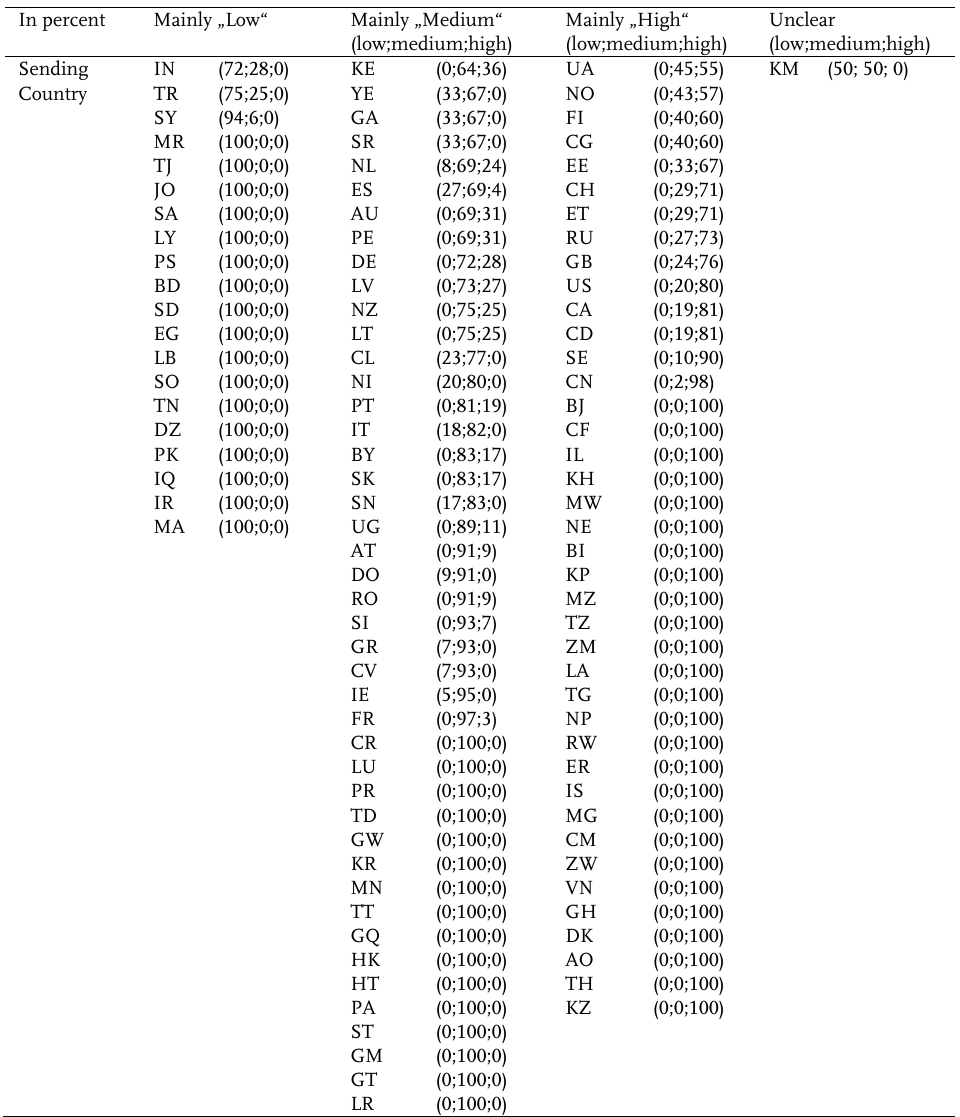
Table A.7 : Average belonging to sending and receiving contexts based on cases for female immigrants